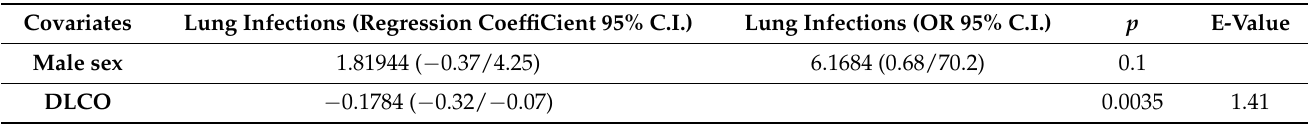
Table 3. Logistic regression multivariate analysis.